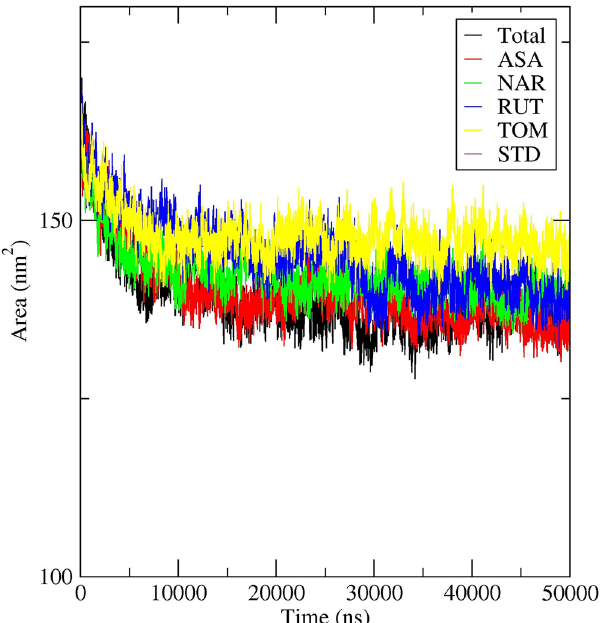
Figure 14. Solvent accessible surface area study plot for 50 ns MD Simulation of 7AQB-APO (Black), 7AQB- ASA (Red), 7AQB-NAR (Green), 7AQB-RUT (Blue) 7AQB-TOM (Yellow) and 7AQB-STD